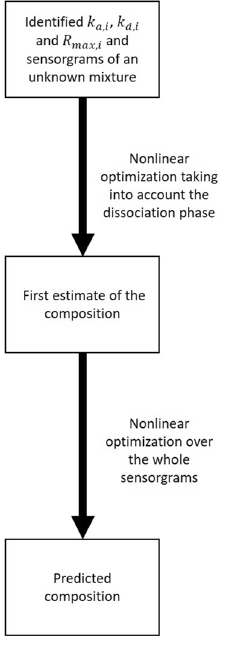
Figure 2. A two-step algorithm for the estimation of the composition of an unknown mixture of N analytes with known kinetic parameters. The starting point for the fraction of each analyte is set to 1 / N for the first optimization routine. This optimization uses only the dissociation phase of the sensorgrams. The results of the first step are used as the starting points of the second optimization routine. Note that the total concentration ( C TOT ) of analytes in the mixture is known, but not the mixture composition (fraction of each